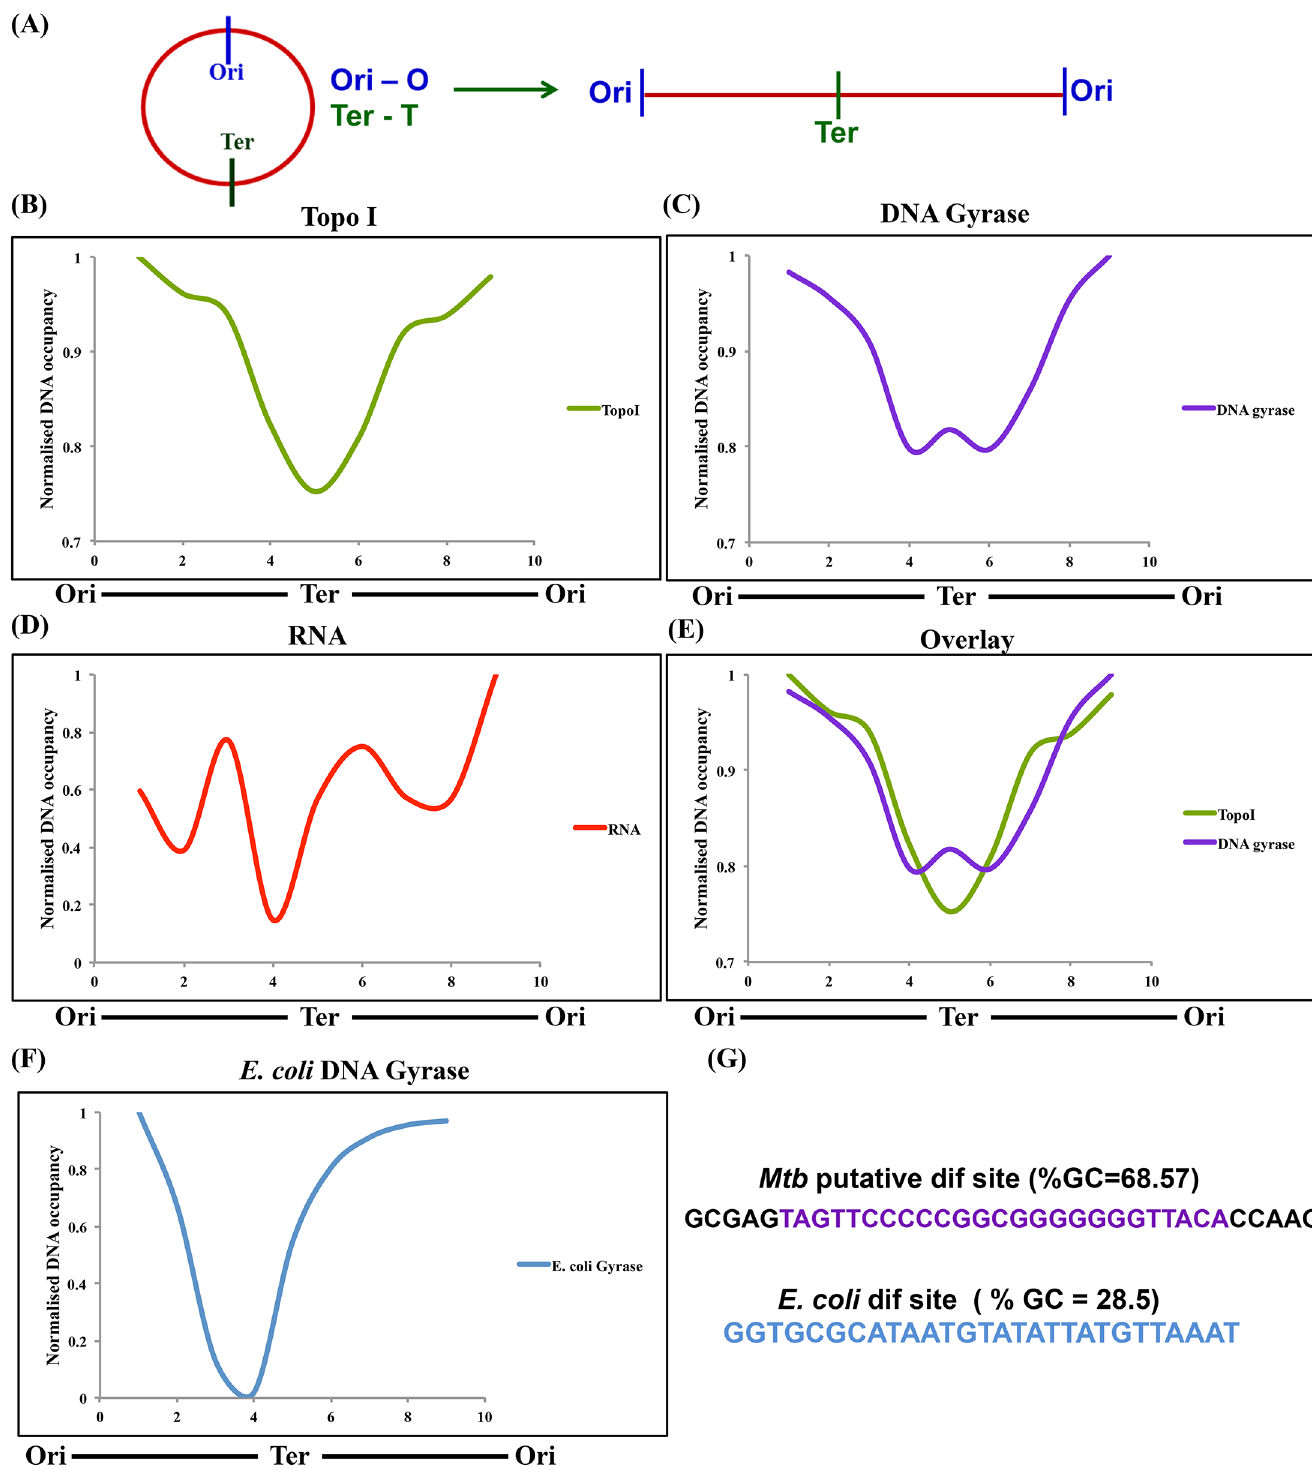
Fig 6. Genome-wide distribution profile of Topo I, DNA gyrase, RNA polymeraseand transcript abundance. Mtb genomewas dividedinto 9 bins (~ 500 kb) and mean read counts in each bin were calculated. The data were normalizedto the input and plotted. The plots represent the linear genome expandingfrom left ori (O) to the right ori . (A) Relativelocalization of ori and ter (T) regionon circular and linear genome.Occupancy profile of (B) Topo I (C) DNA gyrase (D) Transcript abundance across the genomeof Mtb [22] (E) Overlay of Topo I and DNA gyrase (F) Occupancy profile of E . coli DNA gyrase derived from the ChIP-ChIP data [17] (G) Depictionof putative Mtb dif site sequencederivedfrom the gyrase peak at Ter domain.